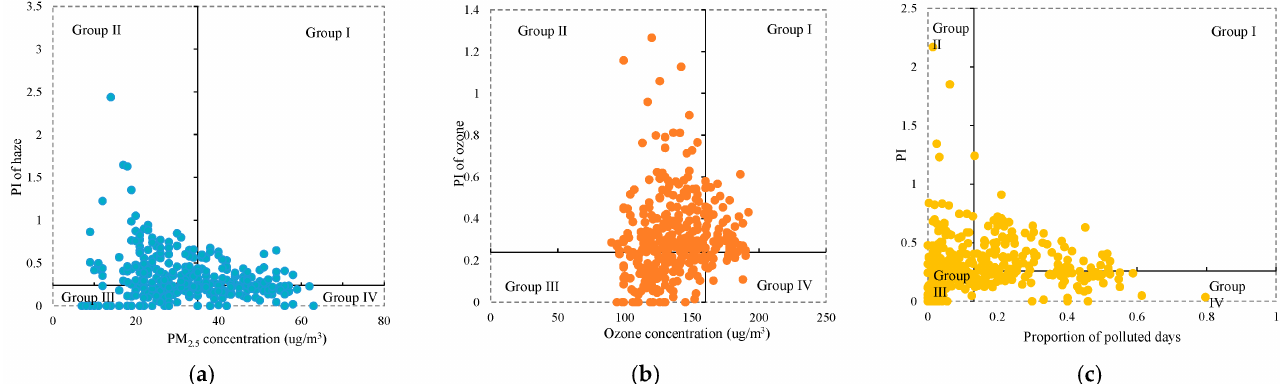
Figure 4. Four-quadrant classification of PI and air quality: ( a ) the four-quadrant classification of PI of haze and PM 2.5 concentration; ( b ) the four-quadrant classification of PI of ozone and its concentration; ( c ) the four-quadrant classification of the comprehensive PI and proportion of polluted days.